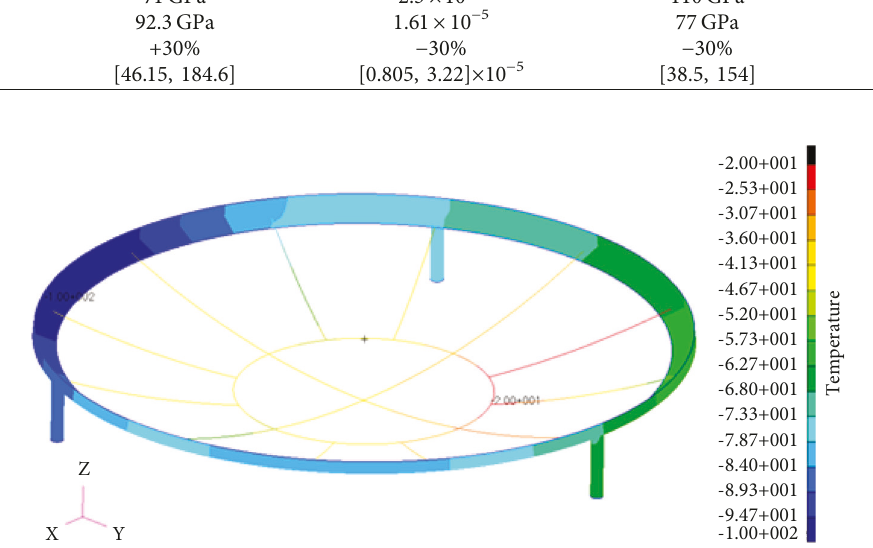
Figure 8: Temperature field of the bottom of the re-entry module.